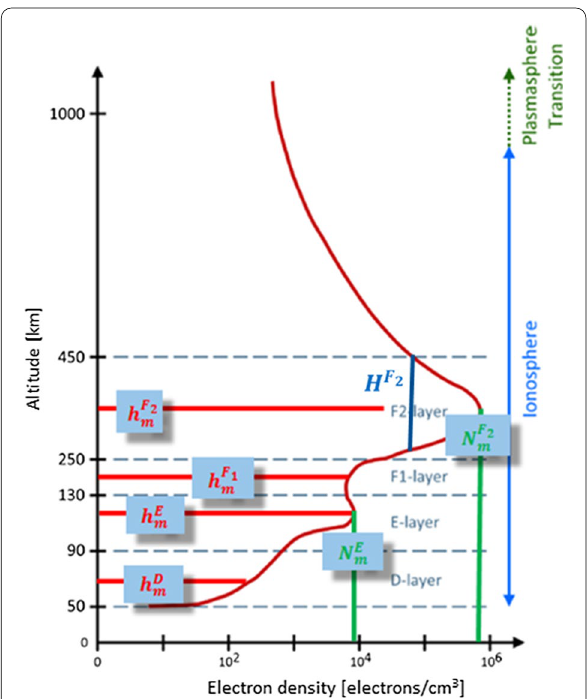
Fig. 1 An approximate representation of vertical electron density profile between h min and h max ; the quantities N Q m ( = maximum value of the electron density, peak density), h Q m ( = peak height) and H Q ( = scale height) are the key parameters of the ionosphere layer Q with Q ∈ { D , E , F 1 , F 2 } . Figure is adapted from Limberger (2015) and is not to accurate scale, but is merely meant for illustration purpose. For a more detailed description of ionospheric profile shape, see e.g. Davies